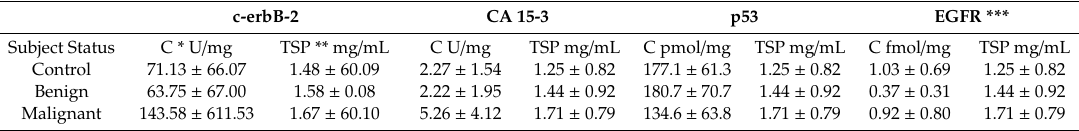
Table 2. Concentration of some notable salivary breast cancer biomarker proteins